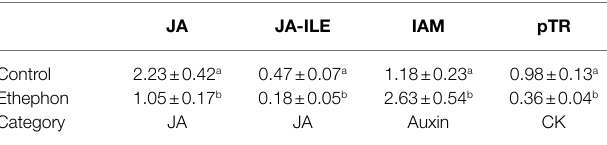
Data are means (ng/g) of three replicates ± SD. Different letters indicate a significant difference between each hormone level of control plants and that of ethephon-treated plants at 5% level as determined by Duncan’s new multiple range test. JA, jasmonic acid; JA-ILE, jasmonoyl-L-isoleucine; IAM, 3-indoleacetamide; pTR, para-topolin riboside; and CK,